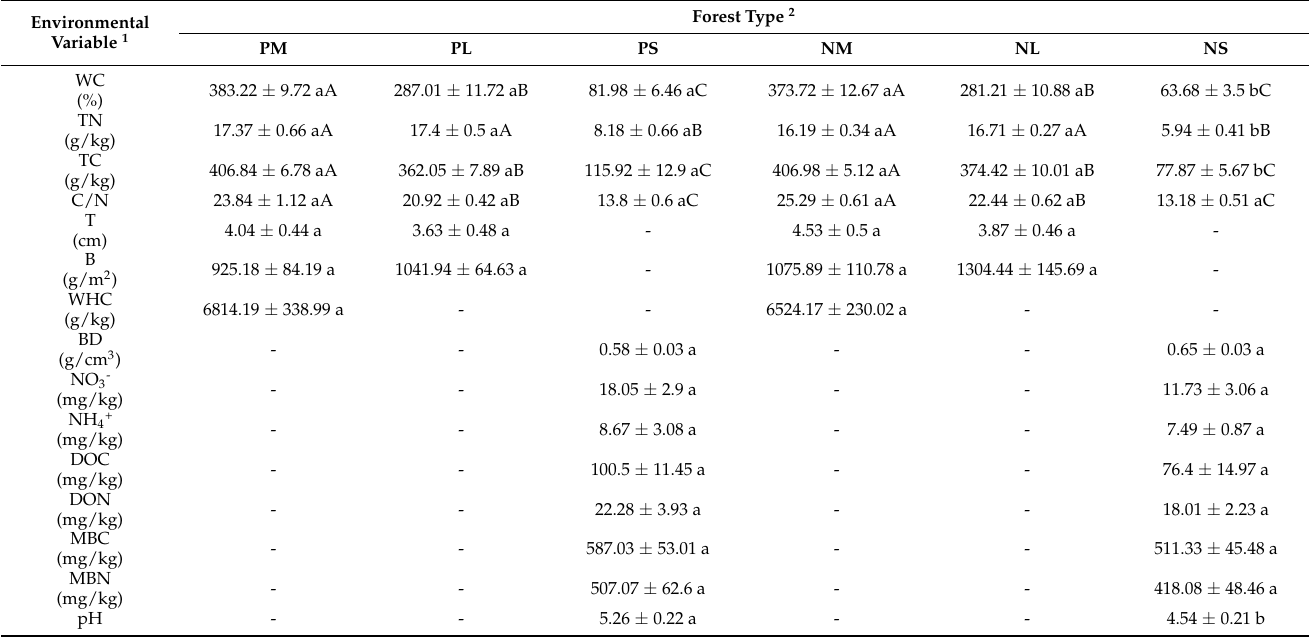
Table 1. Environmental variables in subalpine spruce